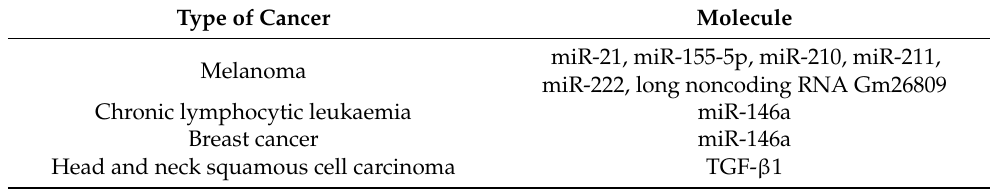
Table 3. Example of CaExo cargo molecules activating fibroblasts/mesenchymal stem cells/CAFs.